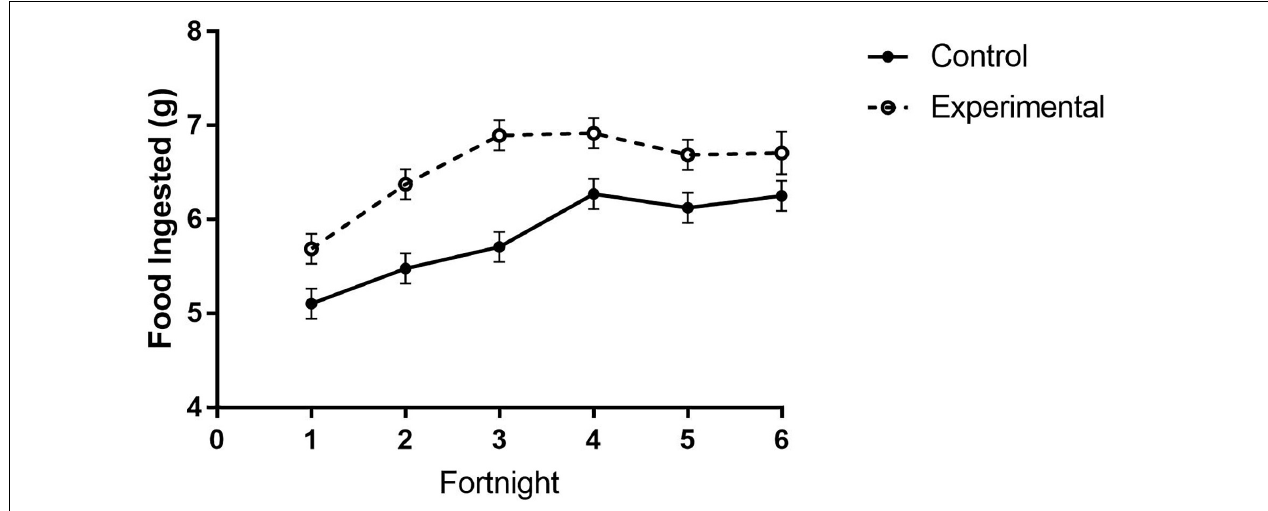
FIGURE 5 | Food consumption of white-throated sparrows in study 2 exposed to high-frequency inclement weather cues or control conditions. Birds that were repeatedly exposed to simulated high-frequency storm cues ingested more food than control birds. Points indicate mean food amounts ingested (g) and error bars indicate